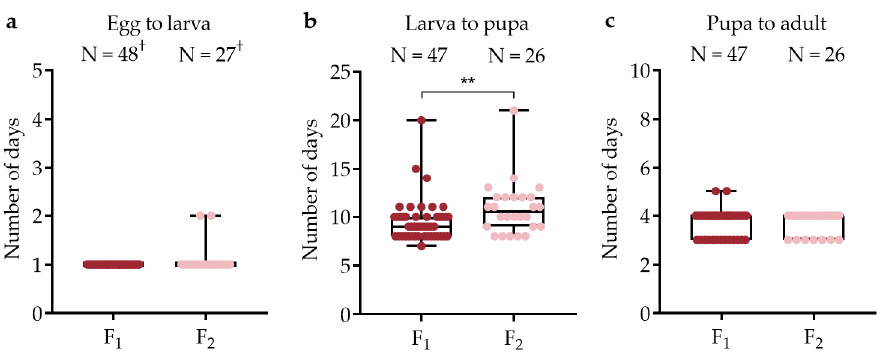
Figure 4. Egg to adult development times for F 1 and F 2 Hg. janthinomys in trays where at least one egg hatched. Box plots show median values and interquartile range (IQR) for development times based on the number of days until the emergence of the first ( a ) larva, ( b ) pupa, and ( c ) adult in each rearing tray. Significant differences indicated by asterisks (** p < 0.01). ‘N =’ = number of trays where at least one egg hatched. † All larvae died in one rearing tray in each